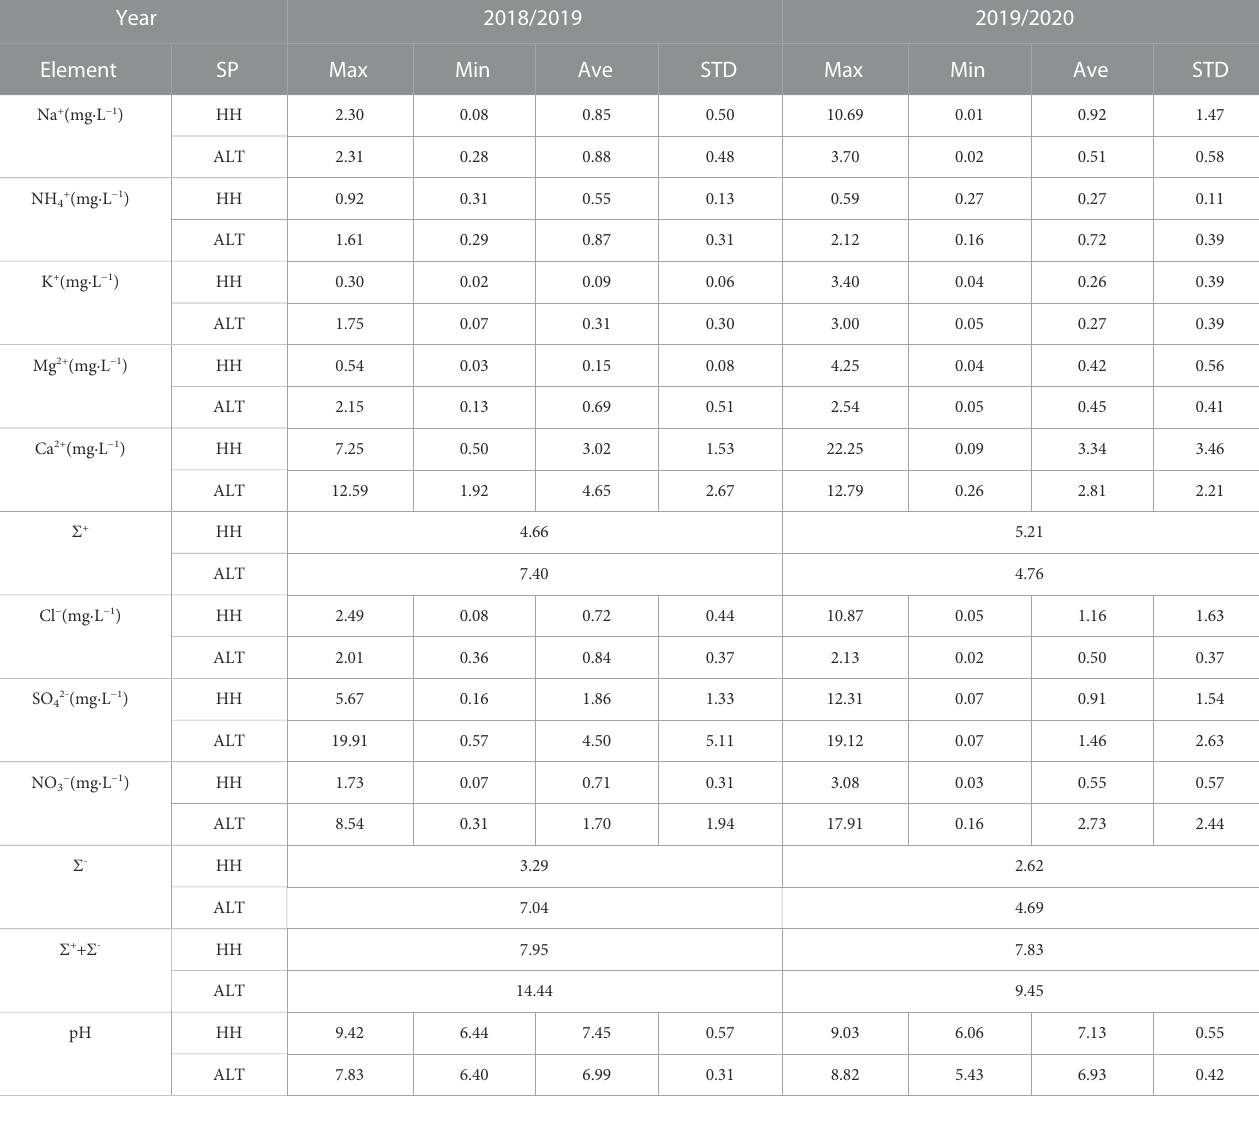
TABLE 2 The concentration of main water-soluble inorganic ions in snow from Heihe (HH) and Altay (ALT). Year